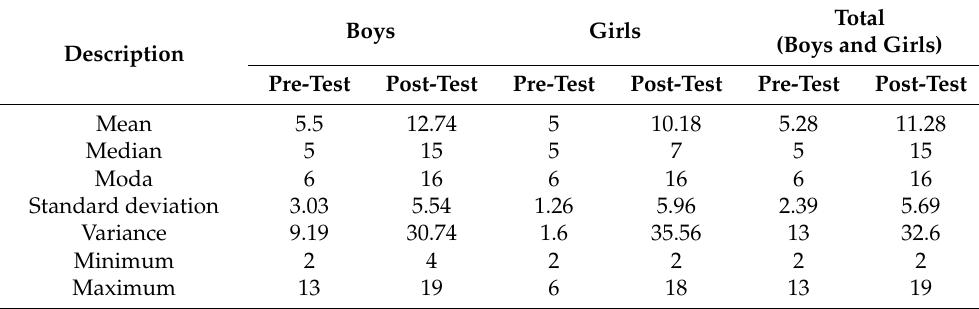
Table 1. Comparison of pre-test and